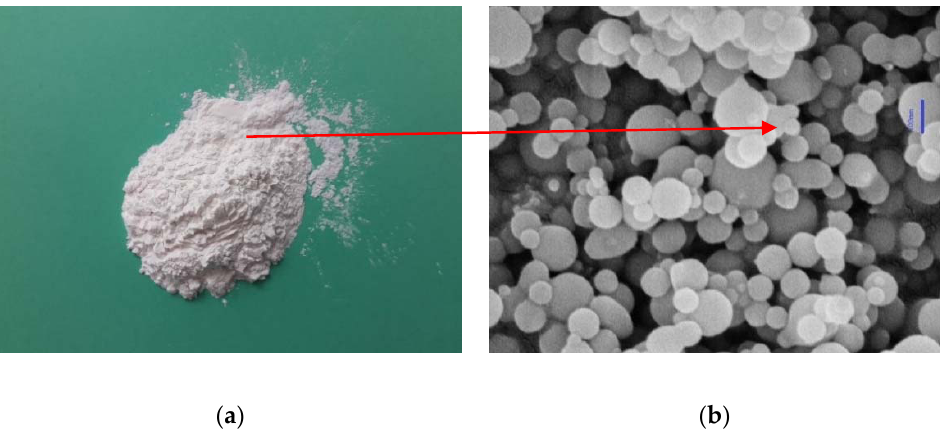
Figure 1. ( a ): nanosilica n ‐ SiO 2 with a grain diameter of approximately 20–30 nm (powdered) used in laboratory tests. ( b ): microstructure of this nanosilica (photograph taken under a scanning microscope) [44]. The arrow marks a single particle of n ‐ SiO 2 . With respect to nanosized alumina n ‐ Al 2 O 3 , Aluminium Oxide Nanopowder, a product was used in which 99% of particles had diameters of approximately 20–30 nm. Figure 2a,b present n ‐ Al 2 O 3 used during the tests and its structure.